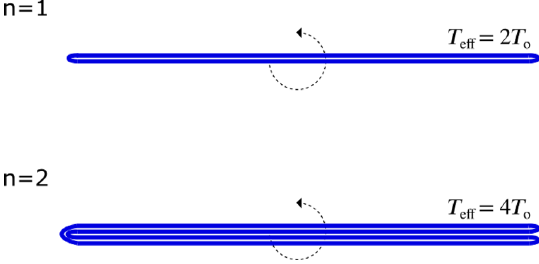
Figure 1 . The rotating folded string has 2 n folding points and effective tension 2 nT o , where T o is the bare tension, or the tension of a non-folded open string. The solutions are drawn with finite width, but the classical solutions we write have zero width, such that the different segments and the folding points